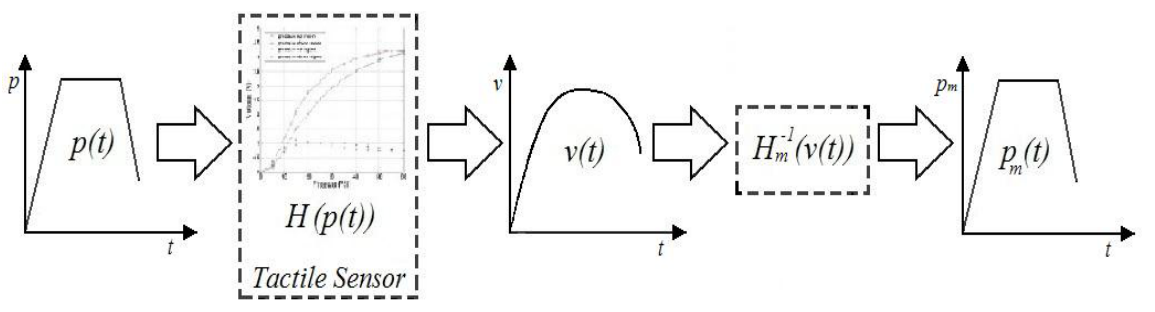
Figure 4. Hysteresis compensation scheme for a tactile